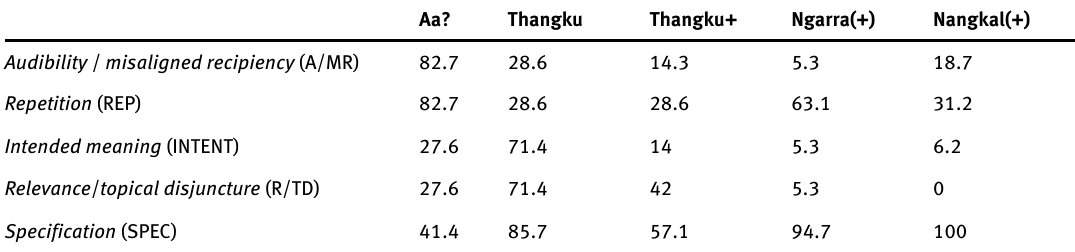
Table 6: The proportion of repair operations (as a % of n) solicited at T+1, per format.